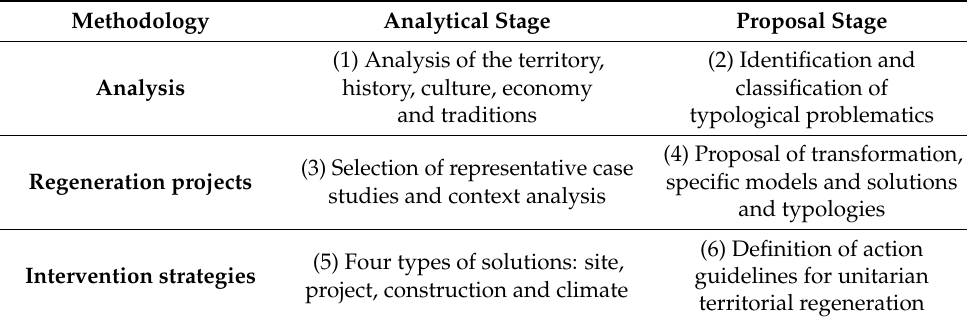
Table 1. Research process based on IAR’s “Mediterranean Strategies”